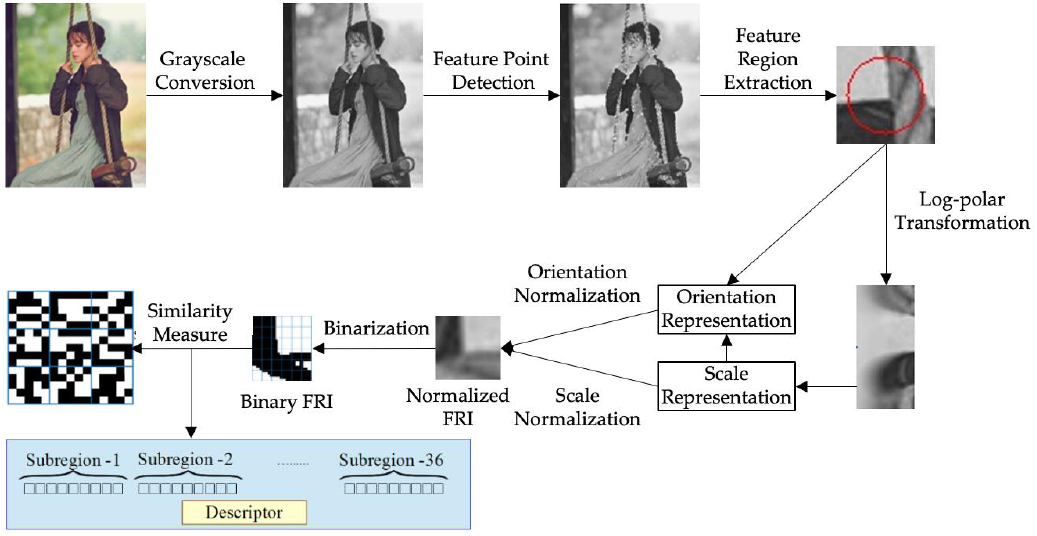
Figure 8. Flowchart of the SR-SYBA algorithm.